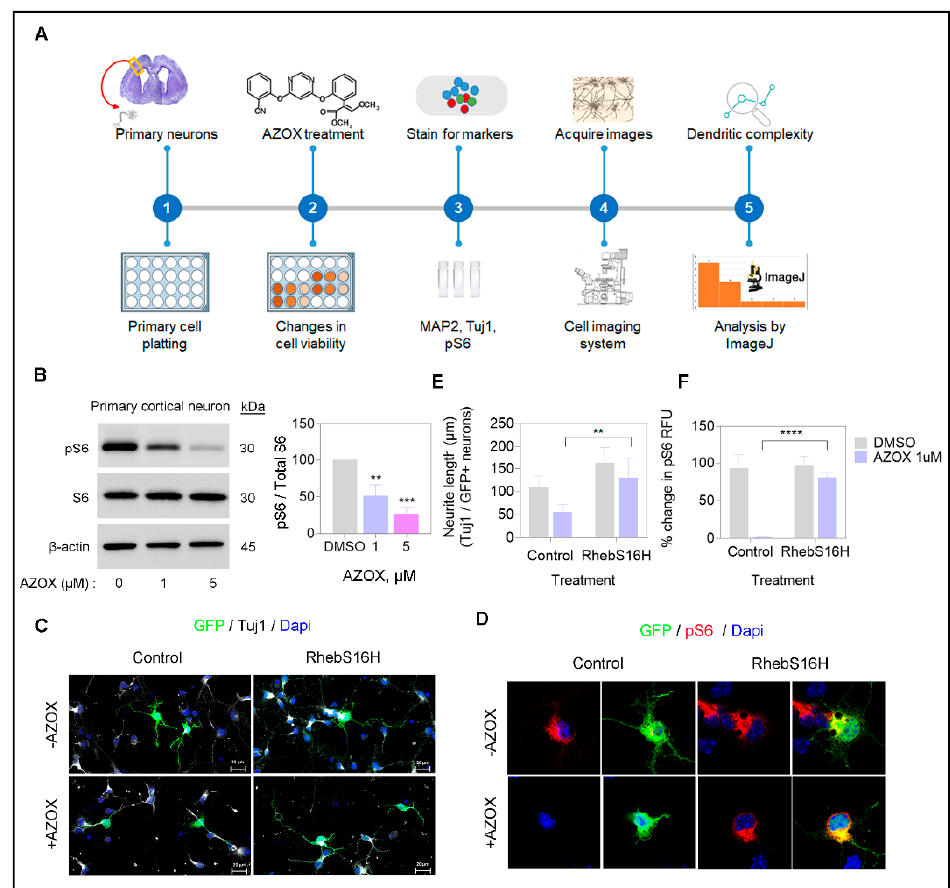
Figure 5. Forced activation of mTORC1 by RhebS16H overexpression rescues neurite loss in AZOX treatment. ( A ) Schematic for evaluating neuronal toxicity and quantification ( B ) pS6 expression level detected by Western blotting. The histogram represents the band intensity, data are presented as mean ± SEM; t -test: ** p < 0.01, *** p < 0.001, **** p < 0.0001. β -actin was used as the loading control. ( C , D ) The neurite length was quantified by immunostaining primary cortical neurons (3 DIV) with Tuj1. Neurons were IUE at E15.5 with a Rheb S16H construct and stained at 3 DIV with anti-GFP (green) and pS6 (red), Tuj1 (Purple). Scale bar, 20 μ m. ( E , F ) Histogram represents the longest neurite length ( t -test: ** p < 0.01). RhebS16H transfected neurons showed longer axons in 1 μ M AZOX treated neurons. The pS6 staining represented mTORC1 activation by Rheb S16H overexpression. Scale bar corresponds to 20 μ m and data are presented as mean ± SEM; t -test: ** p < 0.01, *** p < 0.001, **** p < 0.0001.